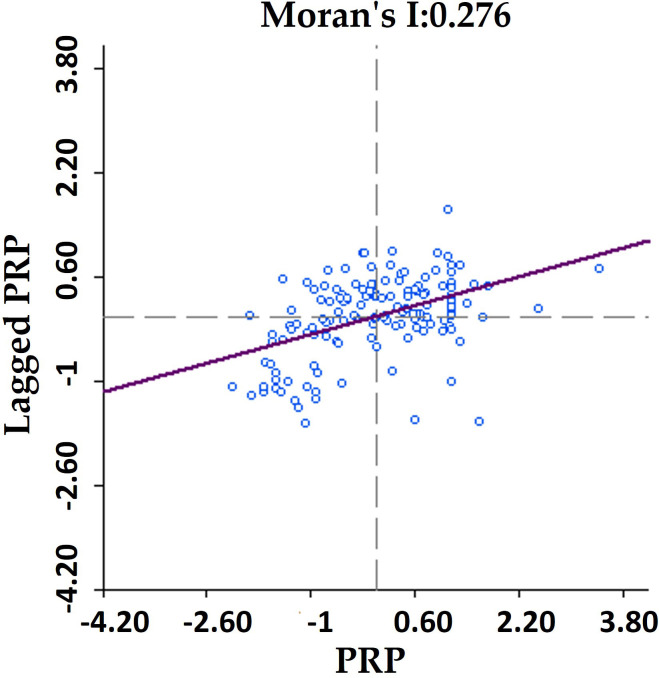
Moran scatter plot of PRP values.